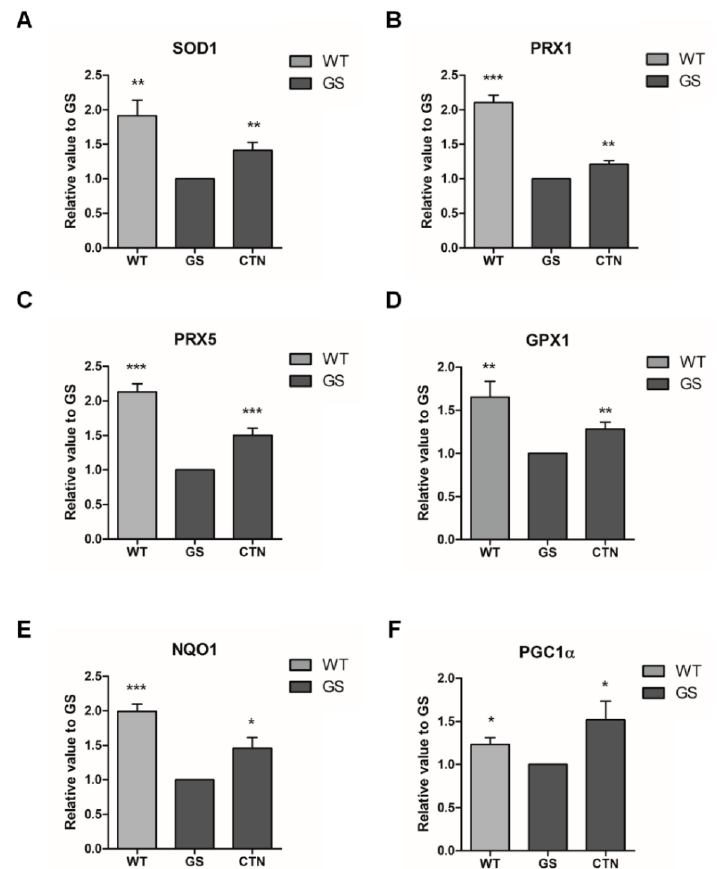
Figure 6. mRNA expression of NRF2 -mediated cytoprotective molecules. Antioxidant molecules, such as ( A ) superoxide dismutase 1 ( SOD1 ), ( B ) peroxiredoxin 1 ( PRX1 ), ( C ) peroxiredoxin 5 ( PRX5 ), ( D ) glutathione peroxidase 1 ( GPX1 ), and ( E ) the phase II antioxidant enzyme NAD(P)H: quinone oxidoreductase 1 ( NQO1 ) were analyzed in WT hiNPCs, GS hiNPCs, and GS hiNPCs treated with CTN (3 μ M) for 24 h followed by MG132 treatment (10 μ M, 24 h). In addition, the mitochondrial biogenesis marker ( F ) peroxisome proliferator-activated receptor γ coactivator-1alpha ( PGC1 α ) was analyzed. Data are mean ± standard error of means (SEM) of at least three independent experiments. p -values were analyzed using the unpaired two-tailed Student’s t -test (* p < 0.05, ** p < 0.005, *** p < 0.001).